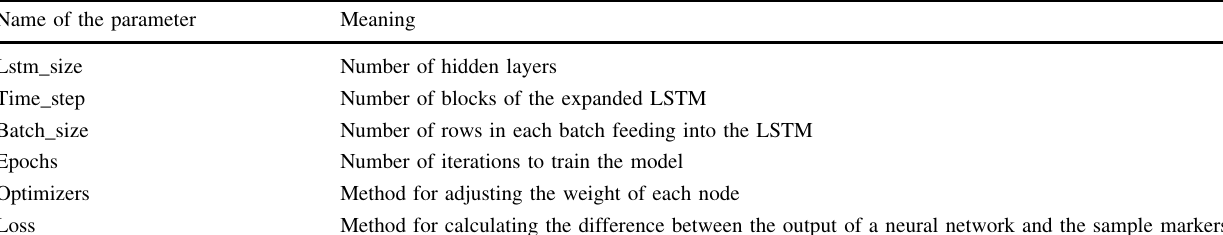
Table 3 The main parameters in the LSTM model